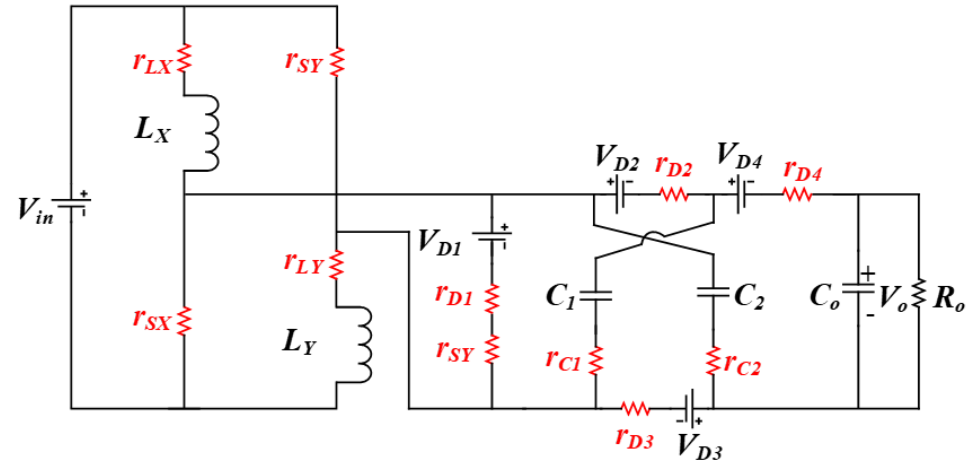
Figure 4. Proposed converter’s equivalent